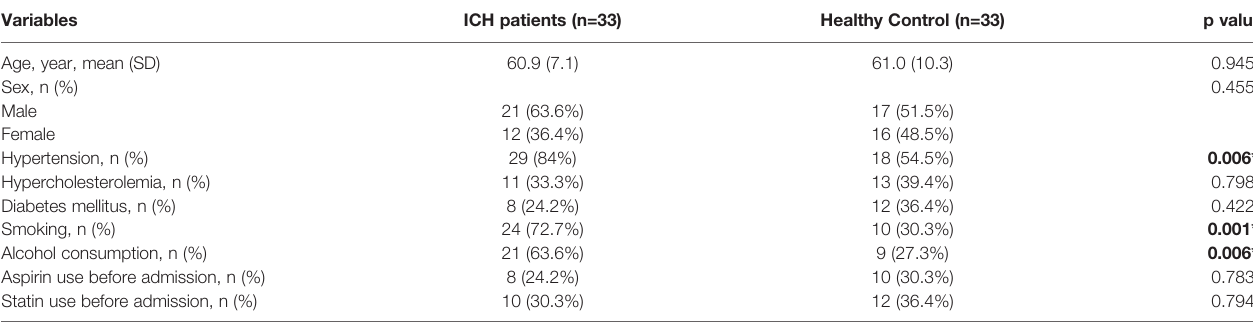
TABLE 1 | Demographic characteristics of patients with ICH and healthy controls.